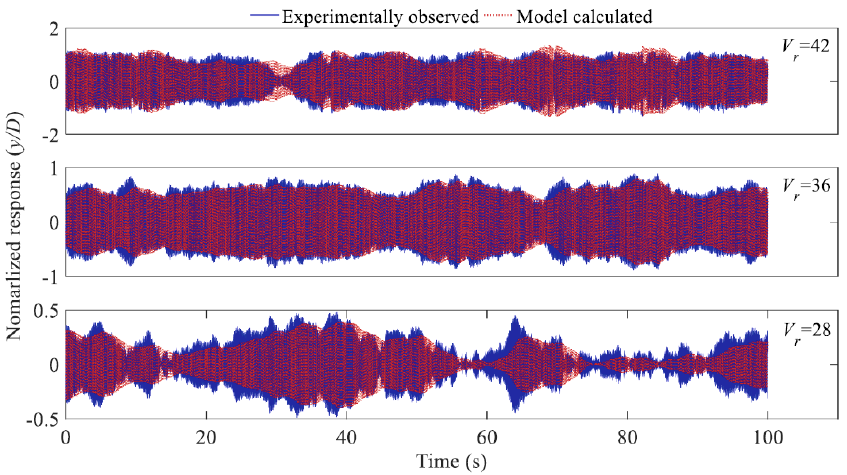
Figure 16. Unsteady aerodynamic forces on the prism: ( a ) In time domain; ( b ) in frequency domain, f vs is the frequency of shedding vortices [25].